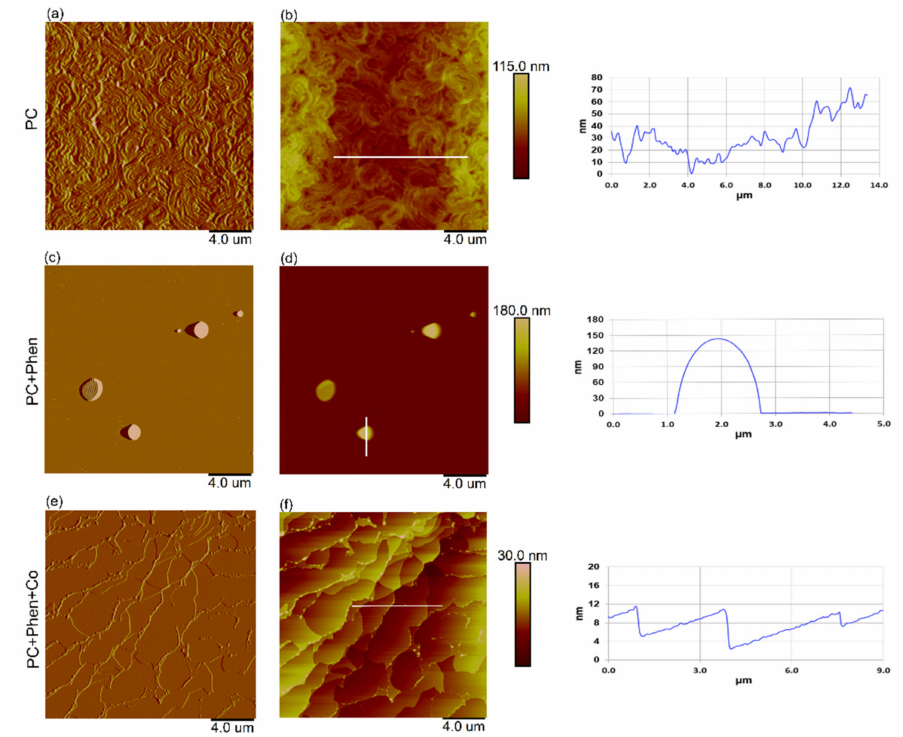
Figure 5. AFM images of PC on mica surface: amplitude data ( a ) and height ( b ) of PC alone; amplitude data ( c ) and height ( d ) of PC with Phen (1:1); and amplitude data ( e ) and height ( f ) of PC, Phen and Co(II) (1:1:1). Heights of cross-sections marked on height images are presented